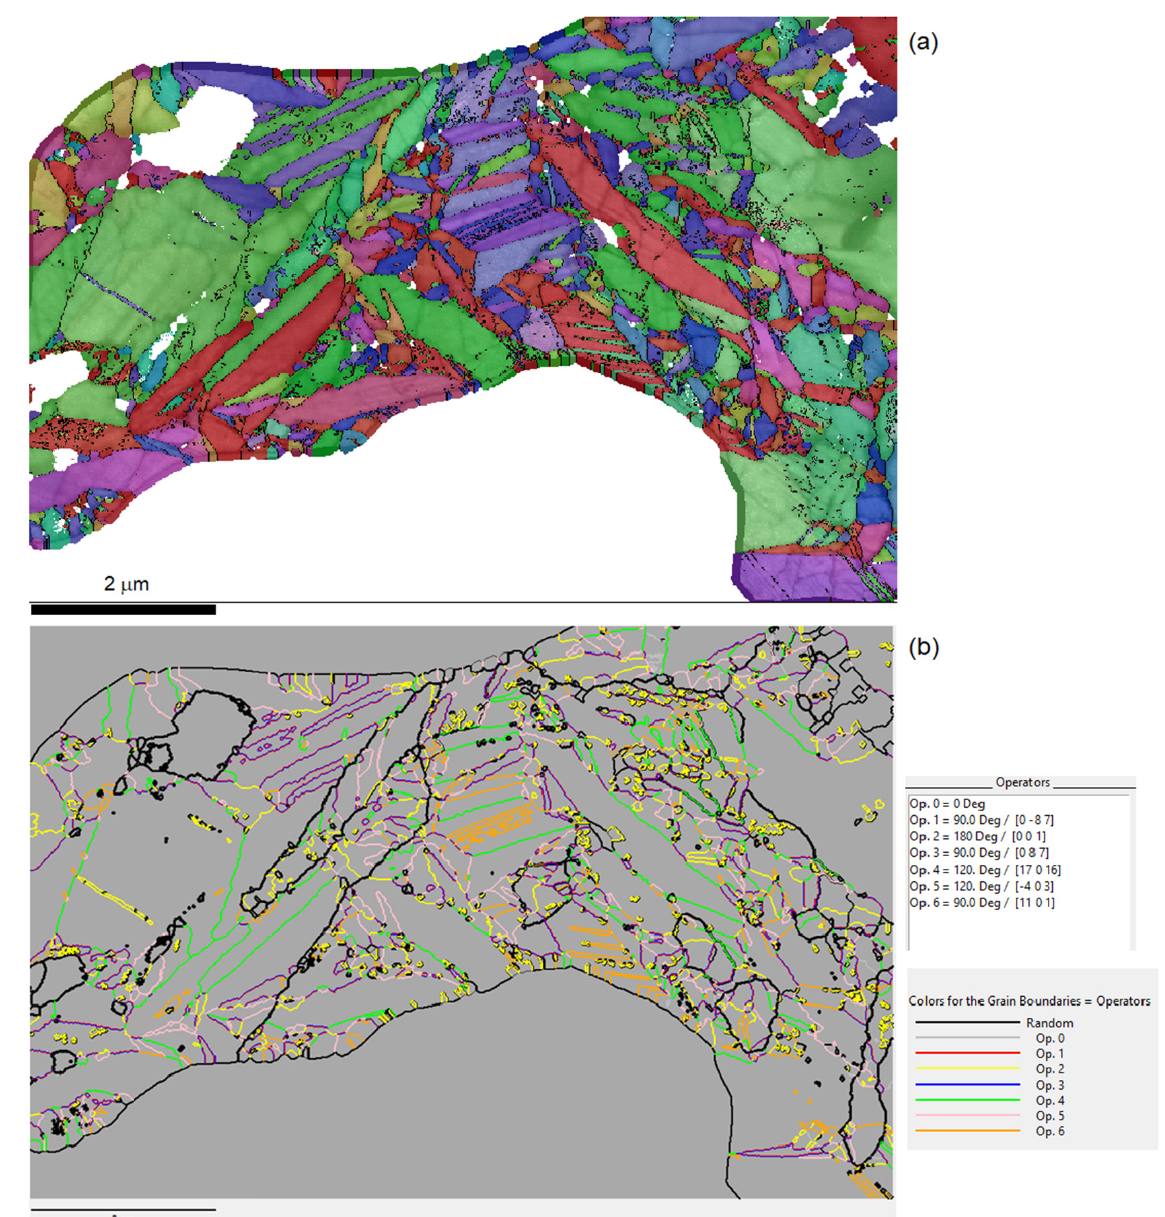
Figure 5. TKD map of a B19 ′ martensitic NiTi alloy. ( a ) IPF-Y colored map of the B19 ′ grains. ( b ) Specific grain boundaries colored in a TKD map according to the operators. The polar operators O 1 and O 3 in red and blue, respectively, overlap on each side of the grain boundaries and merge into a purple color.